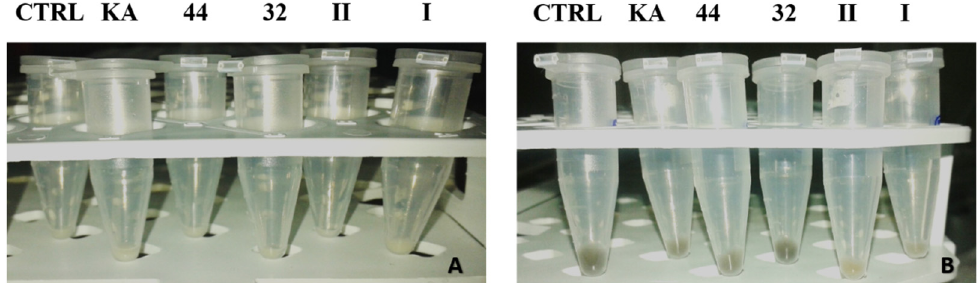
Figure 6. The formed B16F1 ( A ) and B16F10 ( B ) cell pellets post-treatment revealed a whitening or blackening effect.